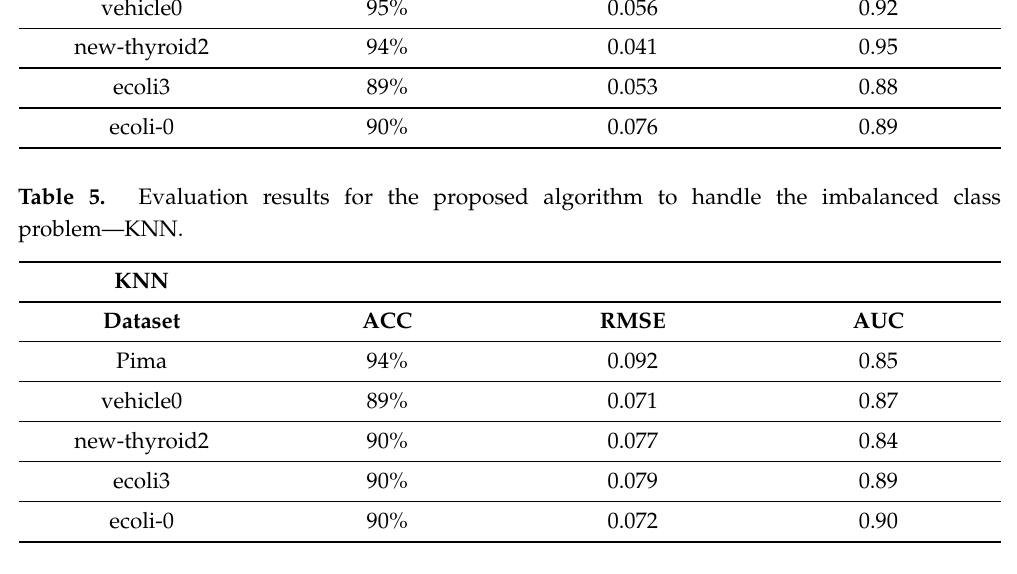
Table 6. Evaluation results for the proposed algorithm to handle the imbalanced class problem— Guo et al.